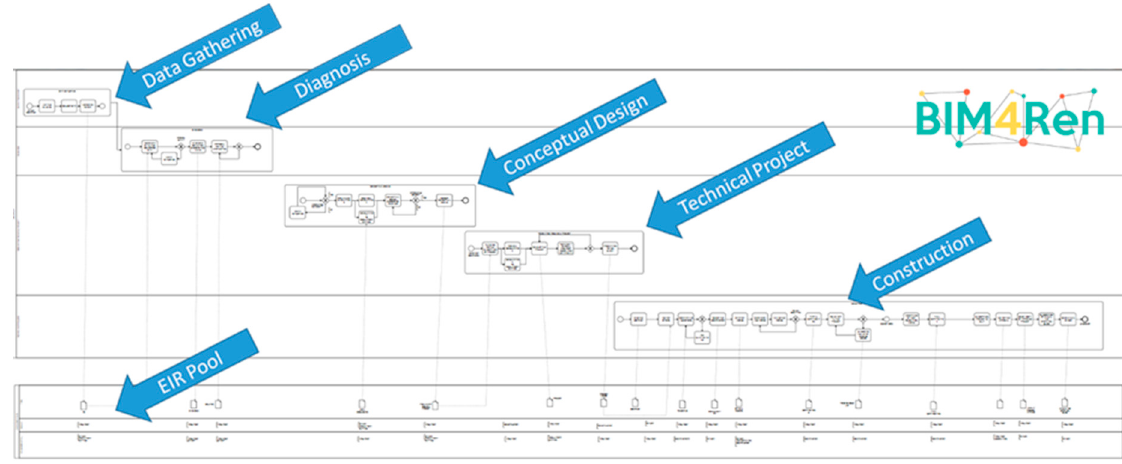
Figure 2. Generic façade renovation BPMN diagram